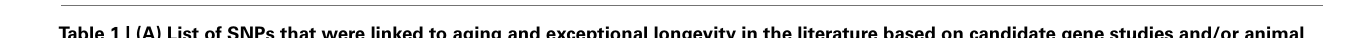
Table 1 | (A) List of SNPs that were linked to aging and exceptional longevity in the literature based on candidate gene studies and/or animal models. Columns 5–7 define the referent allele (Ref Allele), the allele that was associated with longevity (EL Allele), and the frequency of the longevity allele in Caucasians from dbSNP. Boldface highlights genotypes with one or more longevity variants. (B) All additional coding SNPs in the list of candidate genes in which PG17 or PG26 carry non-referent alleles. Column 7 (CEU) reports the frequency of the referent alleles in Caucasians from